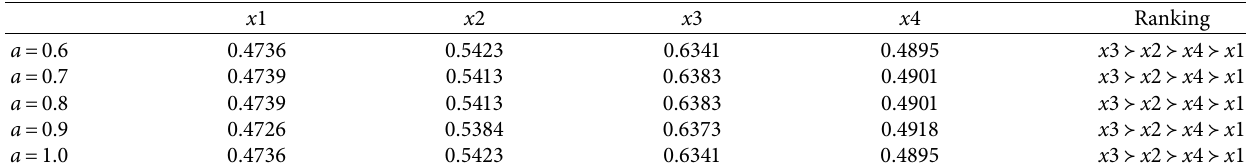
Table 25: .e score for each alternative with the difference value of a .